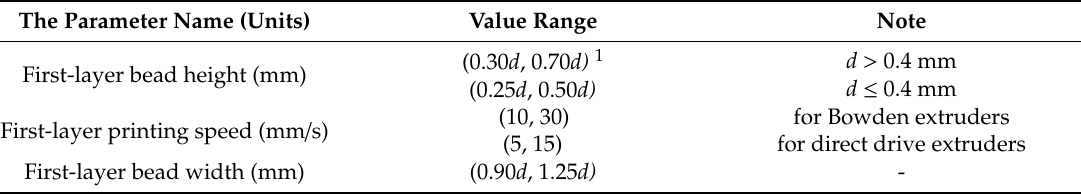
Figure 2. Test geometry consists of (top view) (i) a wipe strip, (ii) a square raft structure to support (test structures), and (iii) 28 test structures. The values of Parameter 1 increase in columns, from right to left; the values of Parameter 2 increase in rows, from top to bottom. Insets show micrographs of two substructures in an extrusion temperature vs. printing speed test for PA: ( a ) and ( b ) correspond to optimal (268 ◦ C and 25 mm / s) and non-optimal (290 ◦ C and 15 mm / s) PP values, respectively. Other PP values: bead height, 0.20 mm; and nominal bead width, 0.80 mm. Table 2. Default value ranges for key PPs in MEAM for common